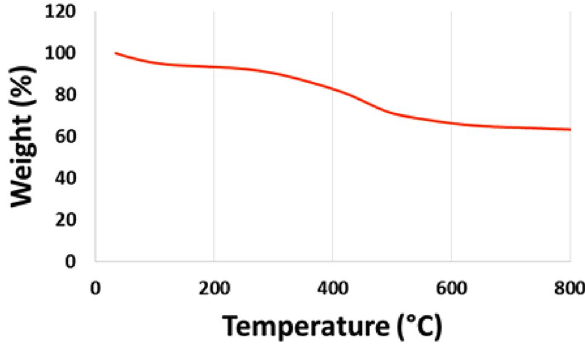
Figure 6. TGA diagram of Sm-bis(PYT)@boehmite.